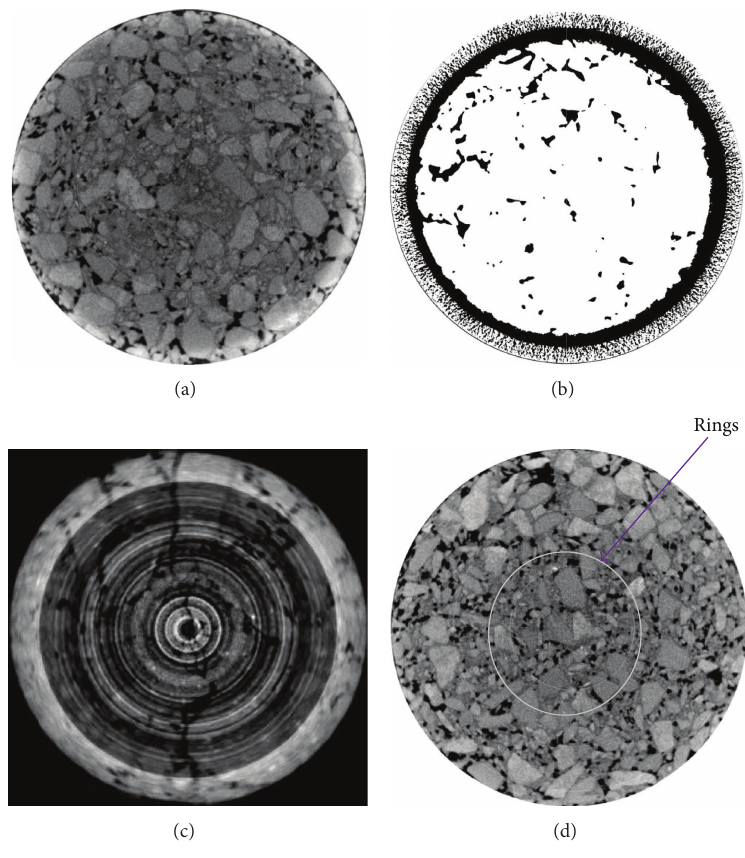
Figure 3: (a) Brightness due to beam hardening; (b) the black outer ring selected as part of air void; (c) high ring artifacts; (d) low ring